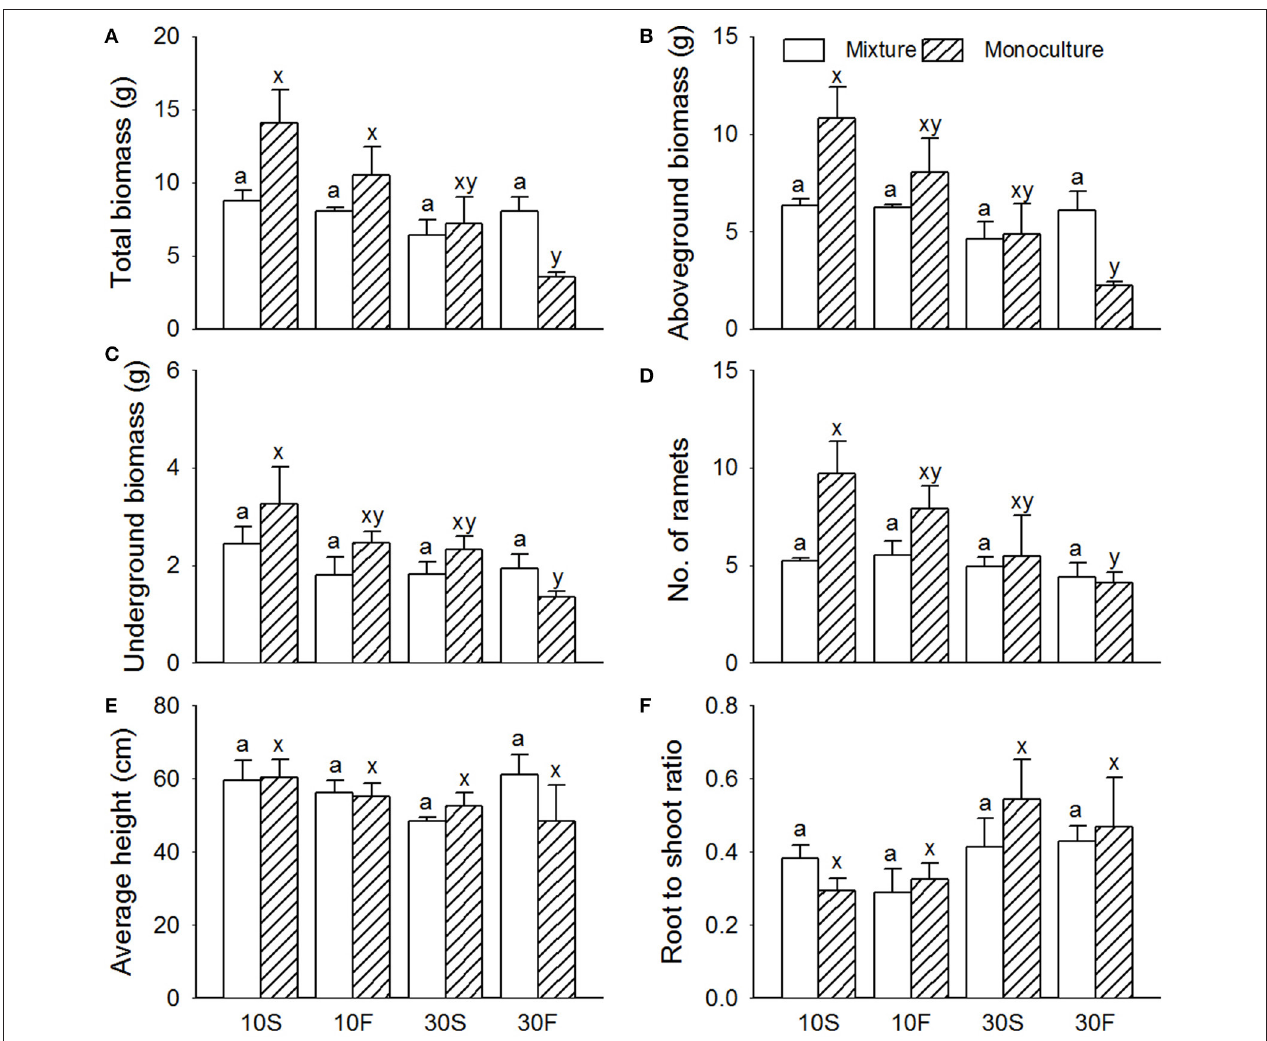
FIGURE 3 | Effects of interspecific interaction and hydrological conditions on the (A) total biomass, (B) aboveground biomass, (C) belowground biomass, (D) number of ramets, (E) average height, and (F) root-to-shoot ratio (mean + SE) of Phragmites australis . Different letters indicate a significant difference among mixture or monoculture treatments (at P <